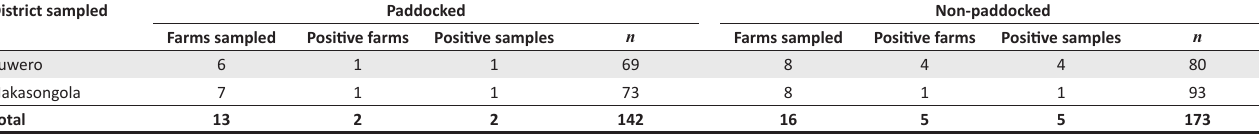
FIGURE 3: Prevalence of antibodies against Brucella abortus by sub-counties in the Nakasongola district. TABLE 1: Grazing systems of sampled farms in the Luwero and Nakasongola districts, Uganda. District sampled Paddocked Non-paddocked Farms sampled Positive farms Positive samples n Farms sampled Positive farms Positive samples